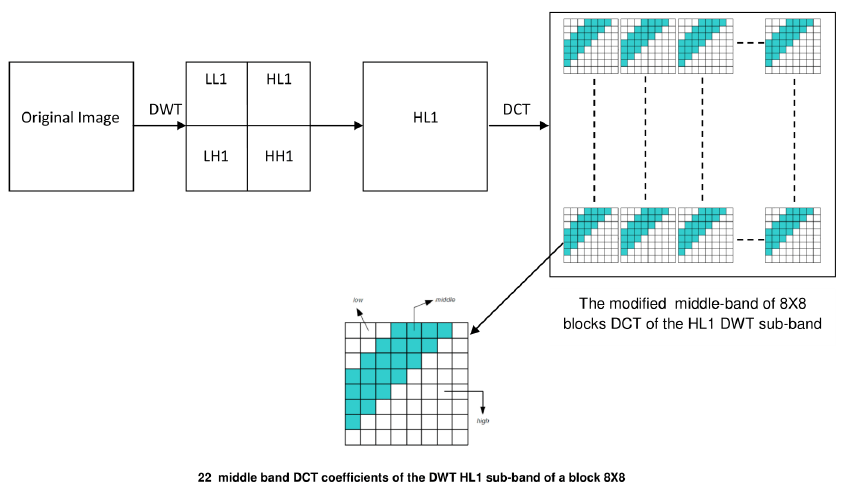
Figure 3. Demonstration of watermark embedding: the watermark is inserted in the 8 × 8 blocks of the DCT middle bands of the HL1 sub-bands of the DWT.